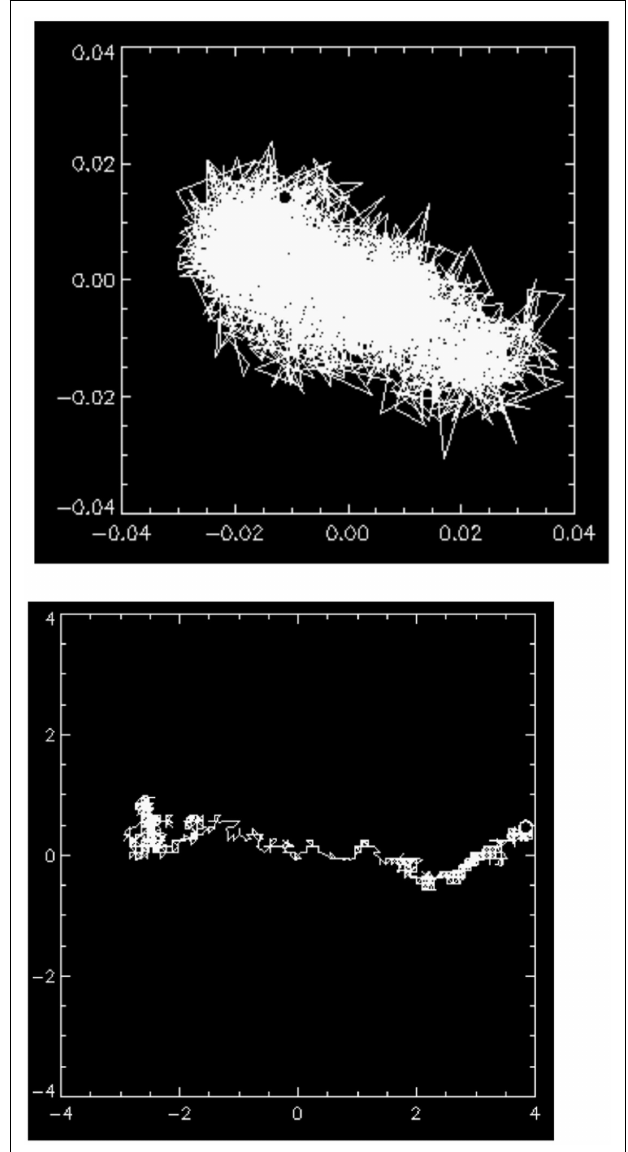
FIGURE 6 | (Top) the motion of the center of mass (c.m) of a 1 µ m latex bead trapped in a pore in the mucin gel at pH 2 .The maximal excursion of the particle’s c.m < 0.1 µ m, indicating that it is essentially immobile in the gel network. (Bottom) occasionally, a particle finds a channel in the gel network indicating that the network structure is heterogeneous.The length unit in both images is micrometer. Reproduced from Celli (80) with author’s